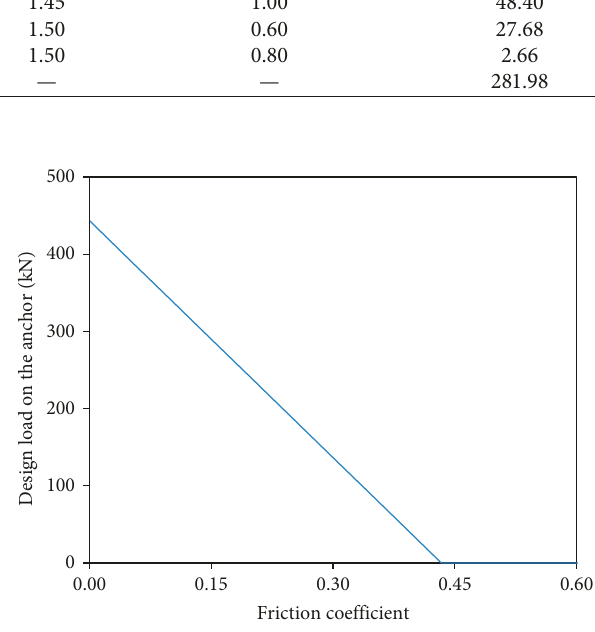
Figure 3: Design load on the anchor considering friction